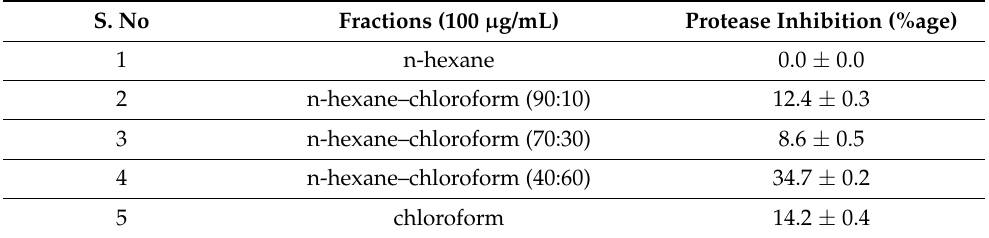
Table 4. Protease inhibition activity of the CC fractions of Camellia sinensis (pH 9.0). S. No Fractions (100 µ